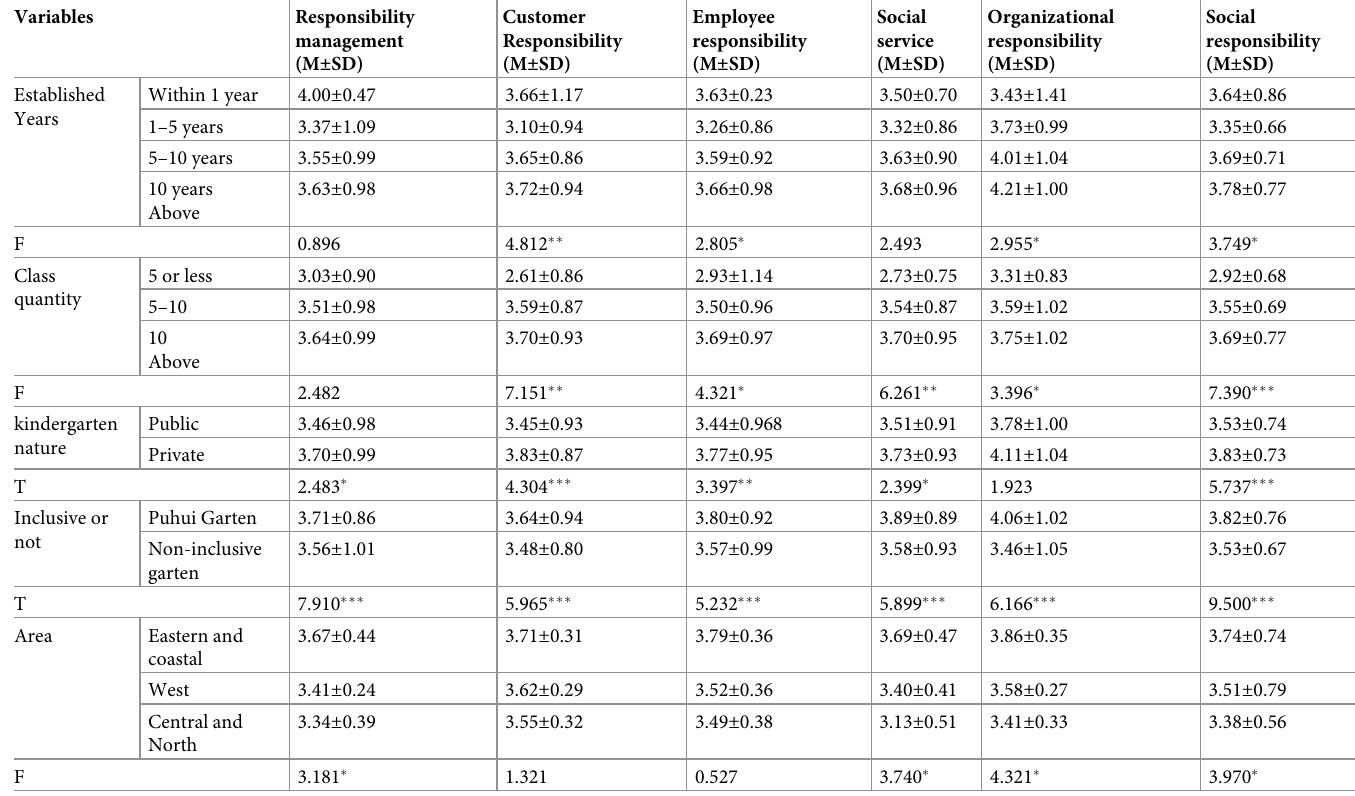
Table 5. Differences in social responsibility performance of various kindergartens.